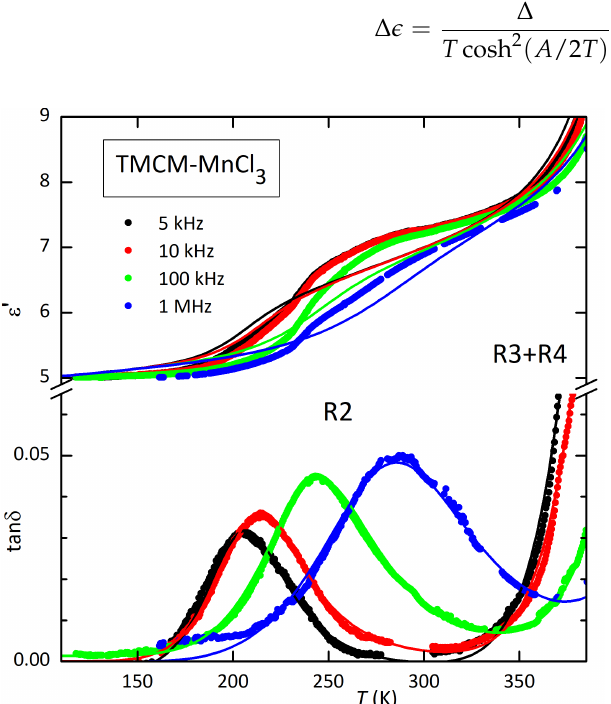
Figure 9. Global fit (thin lines) of the dielectric spectra of TMCM-MnCl 3 measured during cool- ing, with the same set of parameters for all frequencies. R2 is fit with Equations (2) and (3) with τ 0 = 2.6 × 10 − 13 s, E = 4100 K, α = 0.77, γ = 0.65, and A = 650